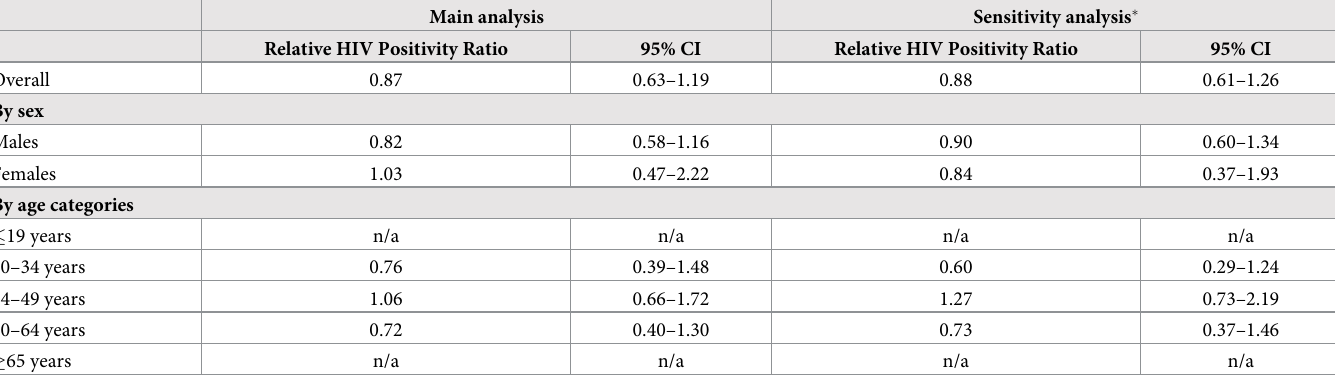
Table 2. Adjusted relative HIV positivity ratios among GPs in Amsterdam after participation in an educational intervention, compared to GPs before participation, overall and by patient sex and age, 2011–2020. Main